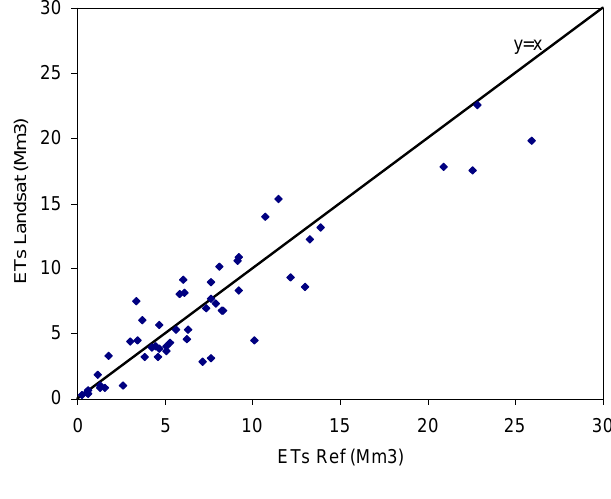
Figure 7 . Comparison of ETs Landsat with reference data in Strimonas river basin, per month and per canal command